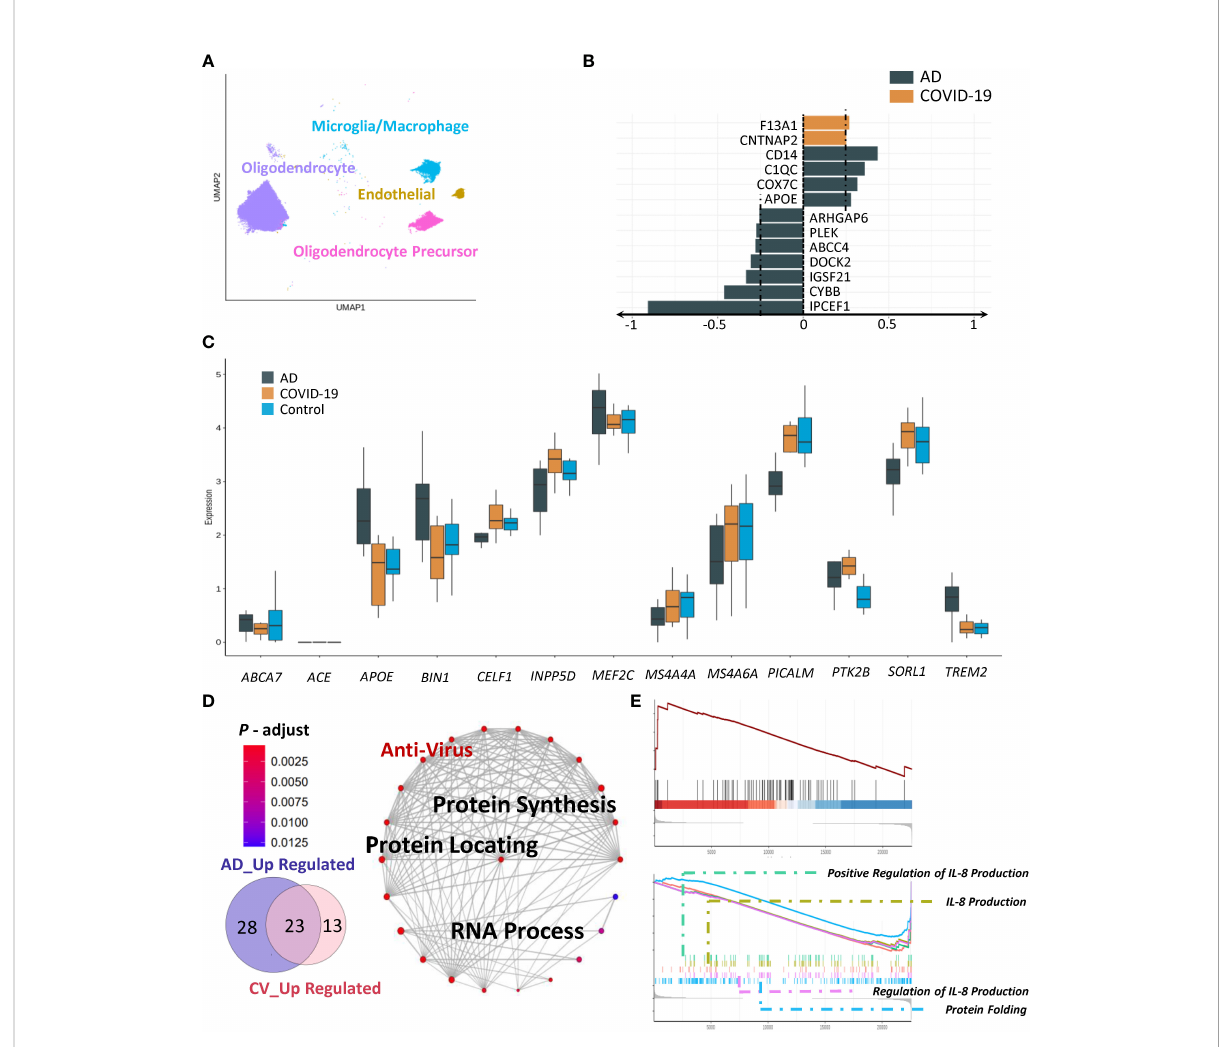
FIGURE 4 Characteristics of disease-associated subpopulations. (A) UMAP embedding of all other cells (Micro-glia/Macrophage, Oligodendrocyte, Endothelial, Oligodendrocyte Precursor) coloured by cell type. (B) Expression of AD-related genes in AD and COVID-19 groups. (C) Changes in disease- associated clusters. (D, E) GSEA and GO enrichment result of microcyte/macrophage showing both anti-virus and cognitive